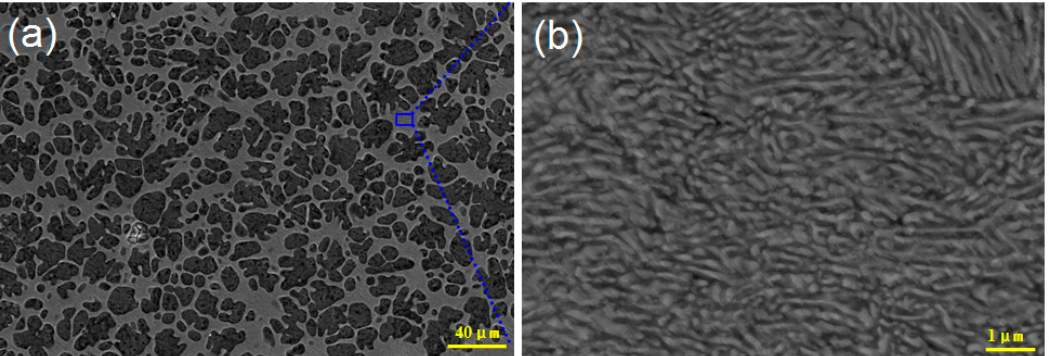
Figure 2. ( a ) Microstructure of Mg–14Ni alloy (designated as alloy B), and ( b ) the magnified scanning electron microscopy image of the eutectic region.